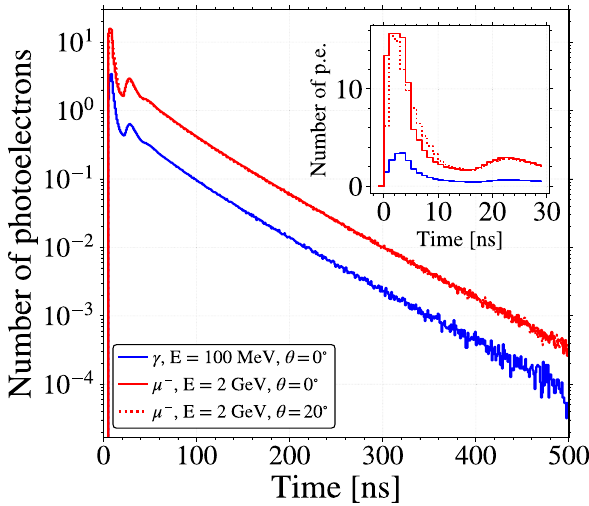
Fig. 5 Average PMT signal time trace for vertical gammas and muons with energies of 100MeV and 2GeV, respectively. Inclined muons with θ = 20 ◦ arealsoshownintheplotasadottedline.Seelegendfordetails